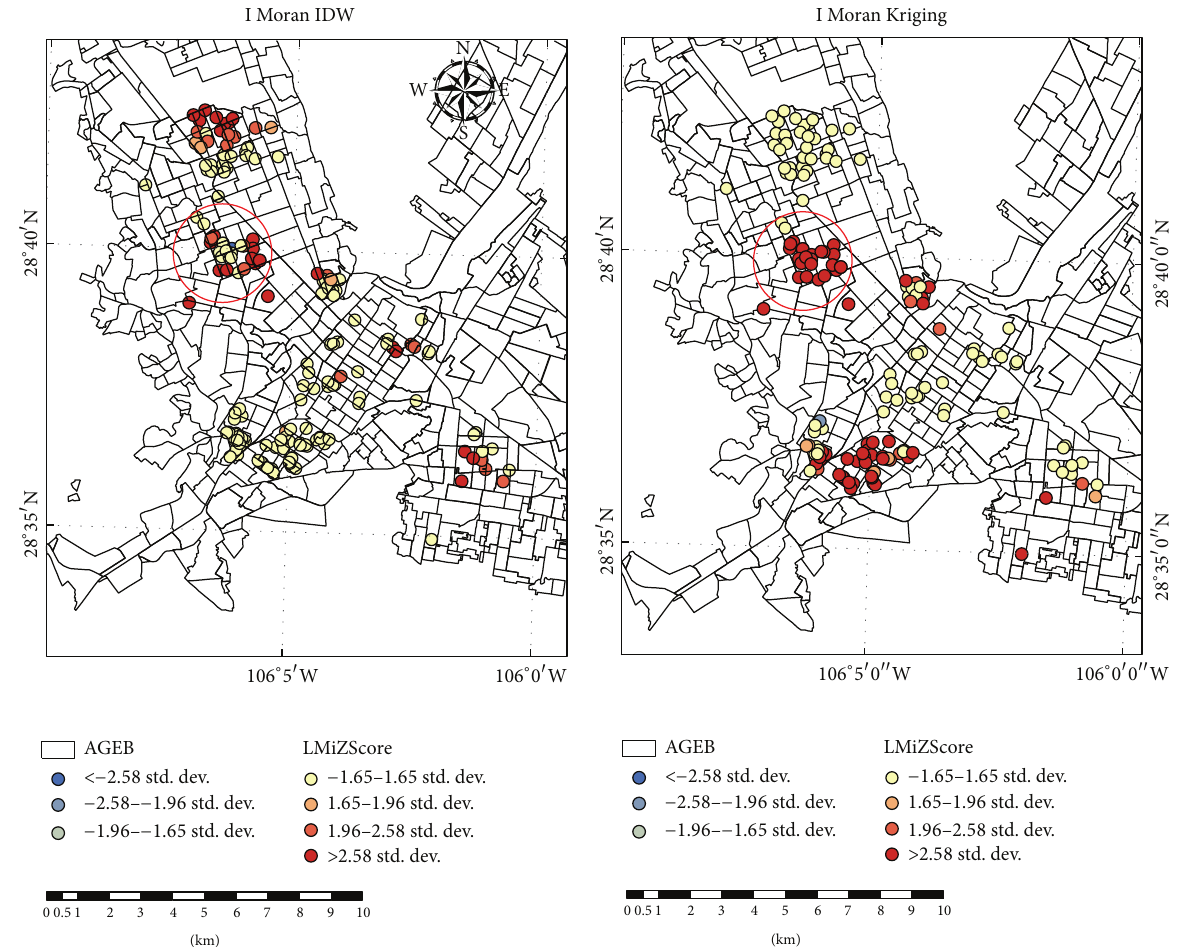
Figure 3: Cluster of LC deaths in Chihuahua City. LMiZScore means Local Moran Index Z score.